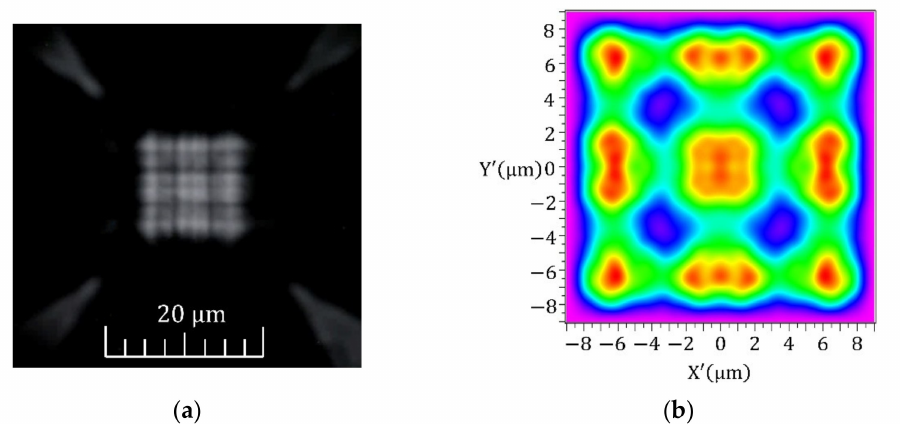
Figure 6. ( a ) Optical microscope image of interference pattern generated by 940 nm excitation and ( b ) simulated optical field distribution for the wavelength of 940 nm.